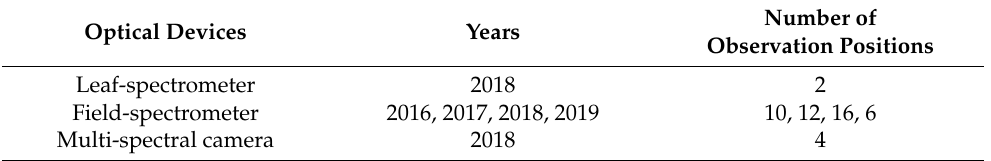
Table 1. Information of optical